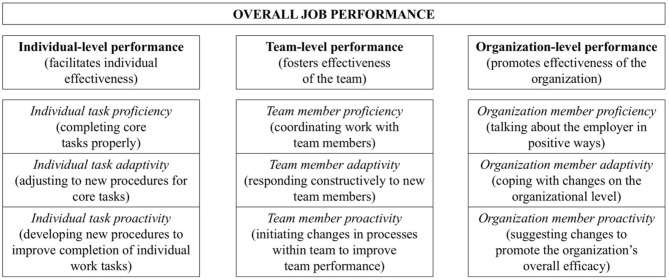
Components and brief definitions of Griffin's (2007) model of job performance.